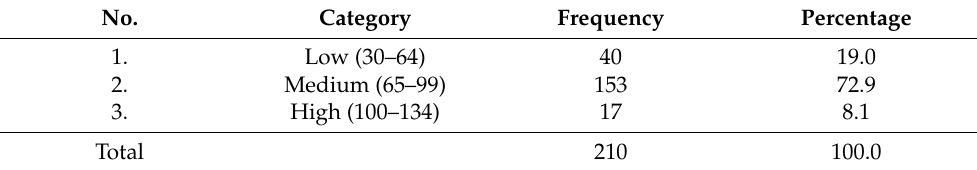
Table 6. Distribution of MSME actors in agriculture by empowerment level in Surakarta. No. Category Frequency Percentage 1. Low (30–64) 40 19.0 2. Medium (65–99) 153 72.9 3. High (100–134) 17 8.1 Total 210